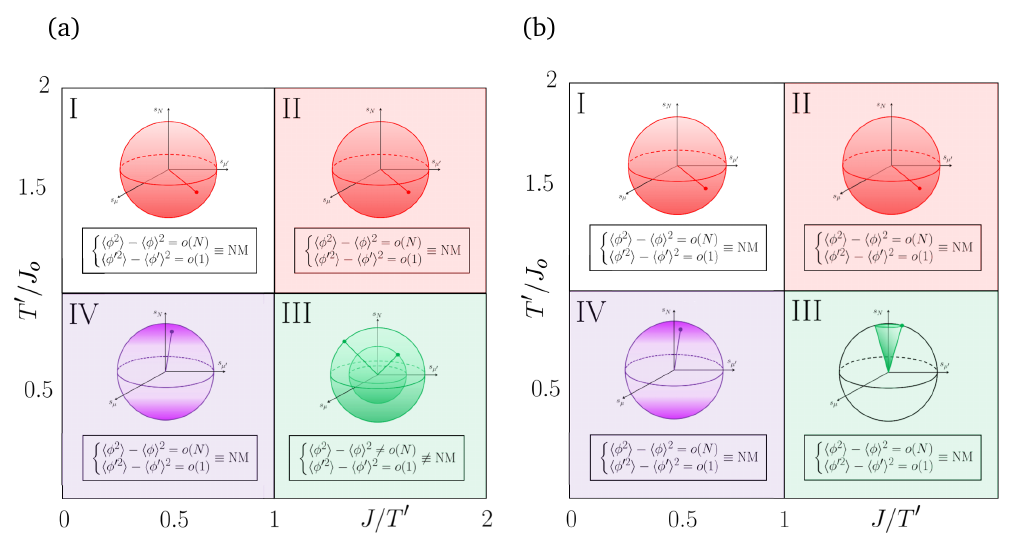
Figure 17: Dynamic phase diagrams and typical trajectories. (a) Symmetric initial conditions. The four phases appear as squares in this representation. The scaling with N of the fluctuations of the primary and secondary constraints in the dynamics of the SNM are written in the four boxes. The spheres represent real space and the location of the typical trajectories are represents by the shaded surfaces in I, II, III and with a curve in IV. In phase III all trajectories are embedded on a sphere but their (cid:112) N . (b) Symmetry broken initial radius is not always